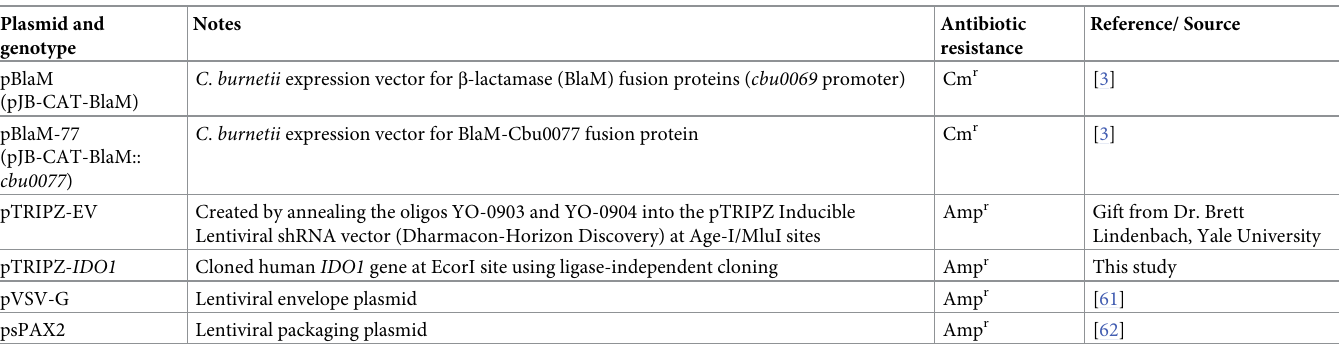
Table 3. Plasmids used in this study.